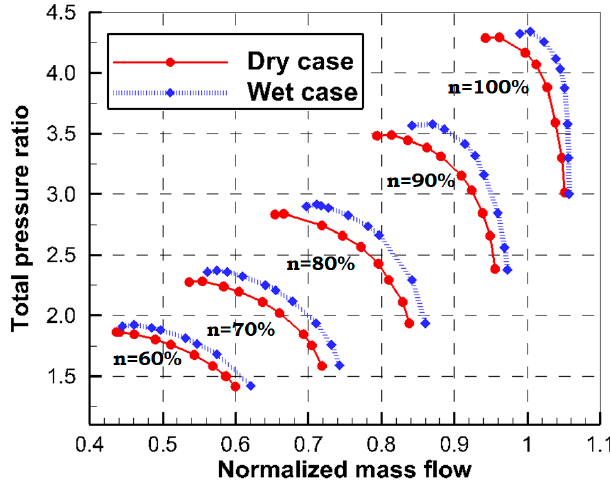
Figure 7. Contrast diagram of pressure ratio under dry and wet cases in a multistage compressor.